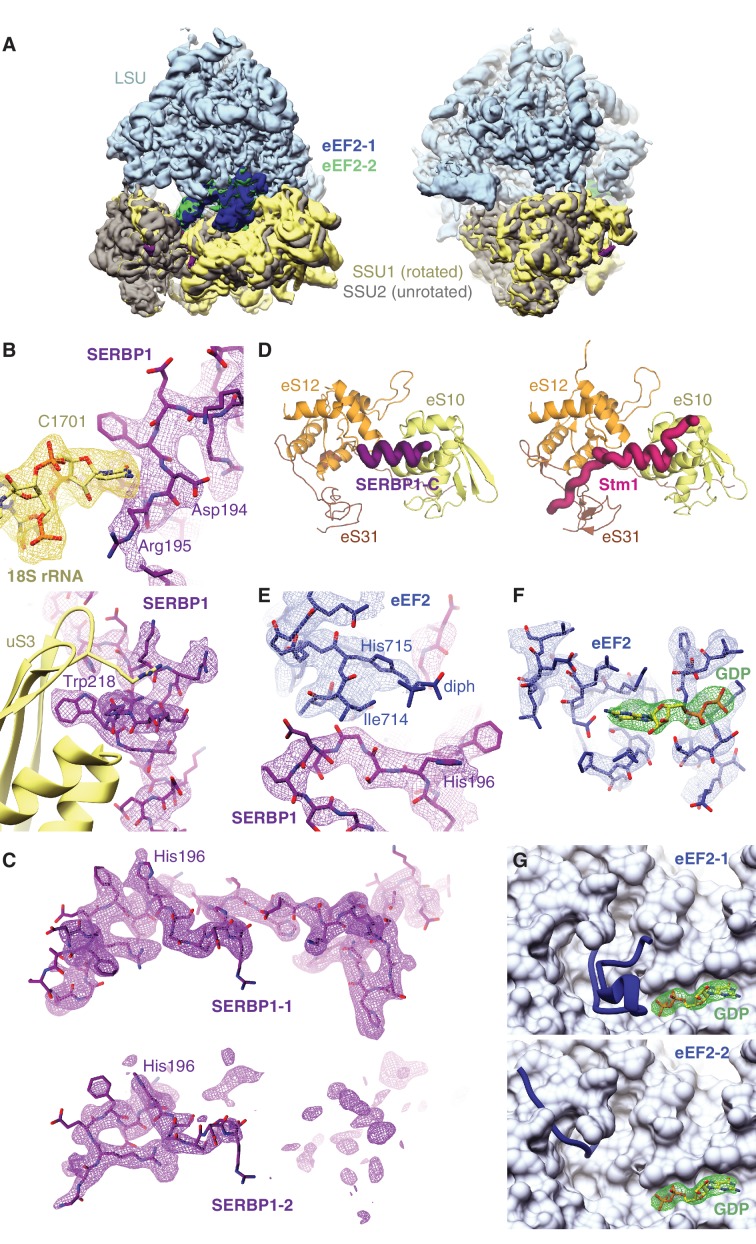
Distinct classes of eEF2 and SERBP1 bound to 80S ribosomes.(A) Overview of the two classes of 80S ribosomes bound to eEF2 and SERBP1 (see Figure 1). The small ribosomal subunit (SSU) in the rotated conformation is colored in yellow, with the corresponding eEF2 density colored in blue. The other unrotated class is aligned to this map via the large ribosomal subunit (LSU), with the corresponding SSU and eEF2 densities colored in grey and green, respectively. (B) Density of SERBP1 (purple) displaying interactions with 18S rRNA and the uS3 protein in the mRNA entrance channel of the small ribosomal subunit (yellow). (C) Comparison of the EM map density for SERBP1 (purple) in the rotated (top) or unrotated (bottom) ribosome. (D) Comparison of the interactions between the C-terminus of either rabbit SERBP1 (purple, left panel) or yeast Stm1 (pink, right panel) with the indicated proteins of the small ribosomal subunit. (E) Map density of the interaction between eEF2 (blue) and SERBP1 (purple). The diphthamide (diph) modification on His715 of eEF2 is indicated. (F) Map density for the GDP nucleotide (green) bound to eEF2 (blue). (G) Comparison of different conformations of the eEF2 nucleotide-binding domain on the rotated (top) and unrotated (bottom) ribosome.